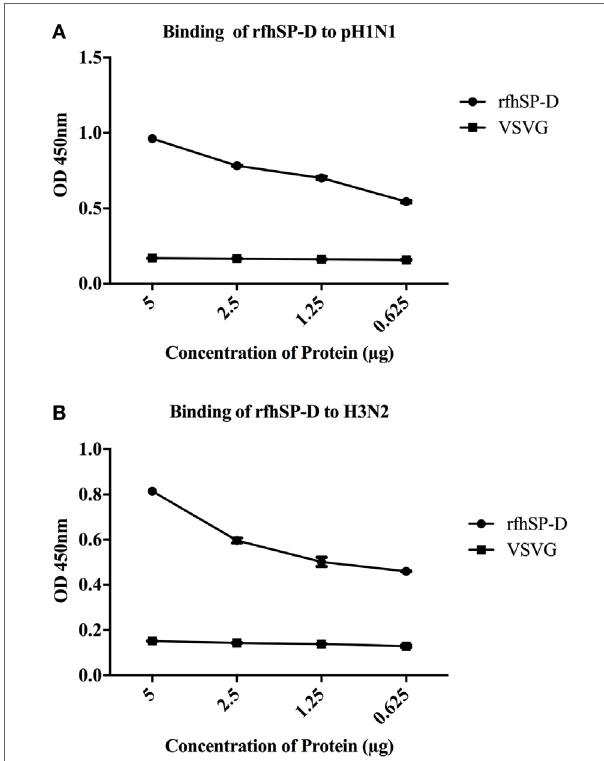
FigUre 2 | ELISA to show binding of rfhSP-D to (a) pH1N1 and (B) H3N2: microtiter wells were coated with different concentrations of rfhSP-D (5, 2.5, 1.25, and 0.625 µg/ml). 20 µl of concentrated pH1N1 or H3N2 virus (1.36 × 10 6 pfu/ml) was diluted in 200 µl of PBS + 5 mM CaCl 2 and 10 µl of diluted virus was added to all the wells, and probed with either monoclonal anti-influenza virus H1 or polyclonal anti-influenza virus H3 antibody. VSV-G pseudotyped lentivirus was used as a negative RNA virus control. The data were expressed as mean of three independent experiments done in triplicates ±